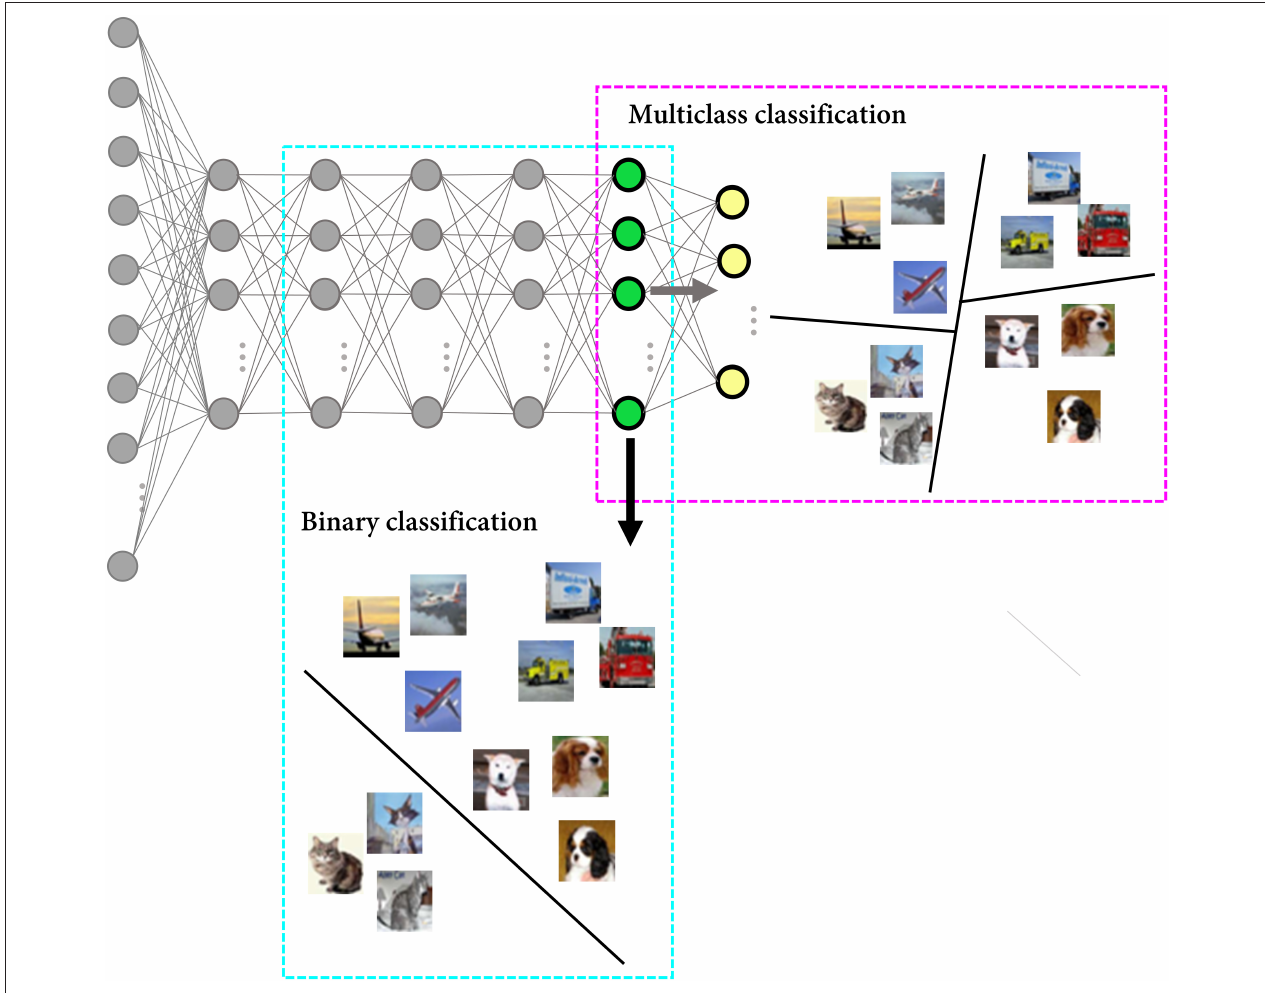
FIGURE 4 | Overestimation of the network feature representation. A schematic figure to explain the difference in the task difficulty depending on the number of exposed labels during model training. While predicting the label of cat images is a multiclass classification problem with 10 class candidates for the DNN model (only 4 classes are presented in the figure for visualization purposes), it is a binary classification task for the linear SVM.